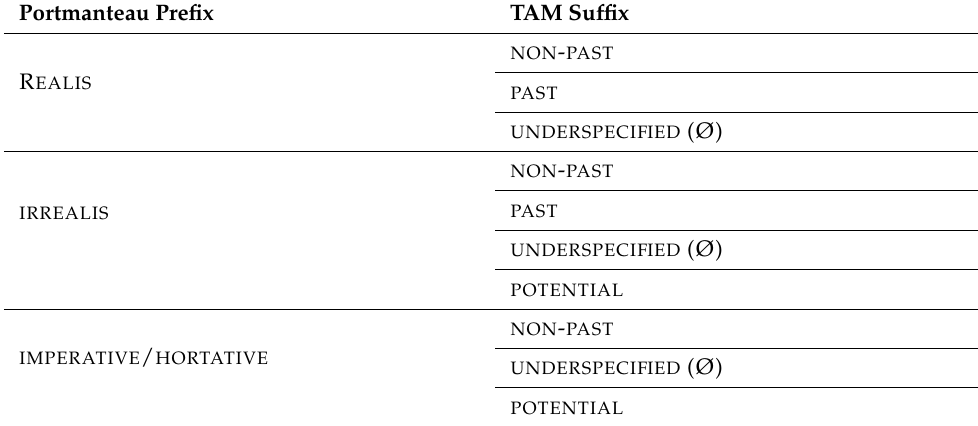
Table 1. Anindilyakwa TAM circumfixal inflectional paradigms (positive